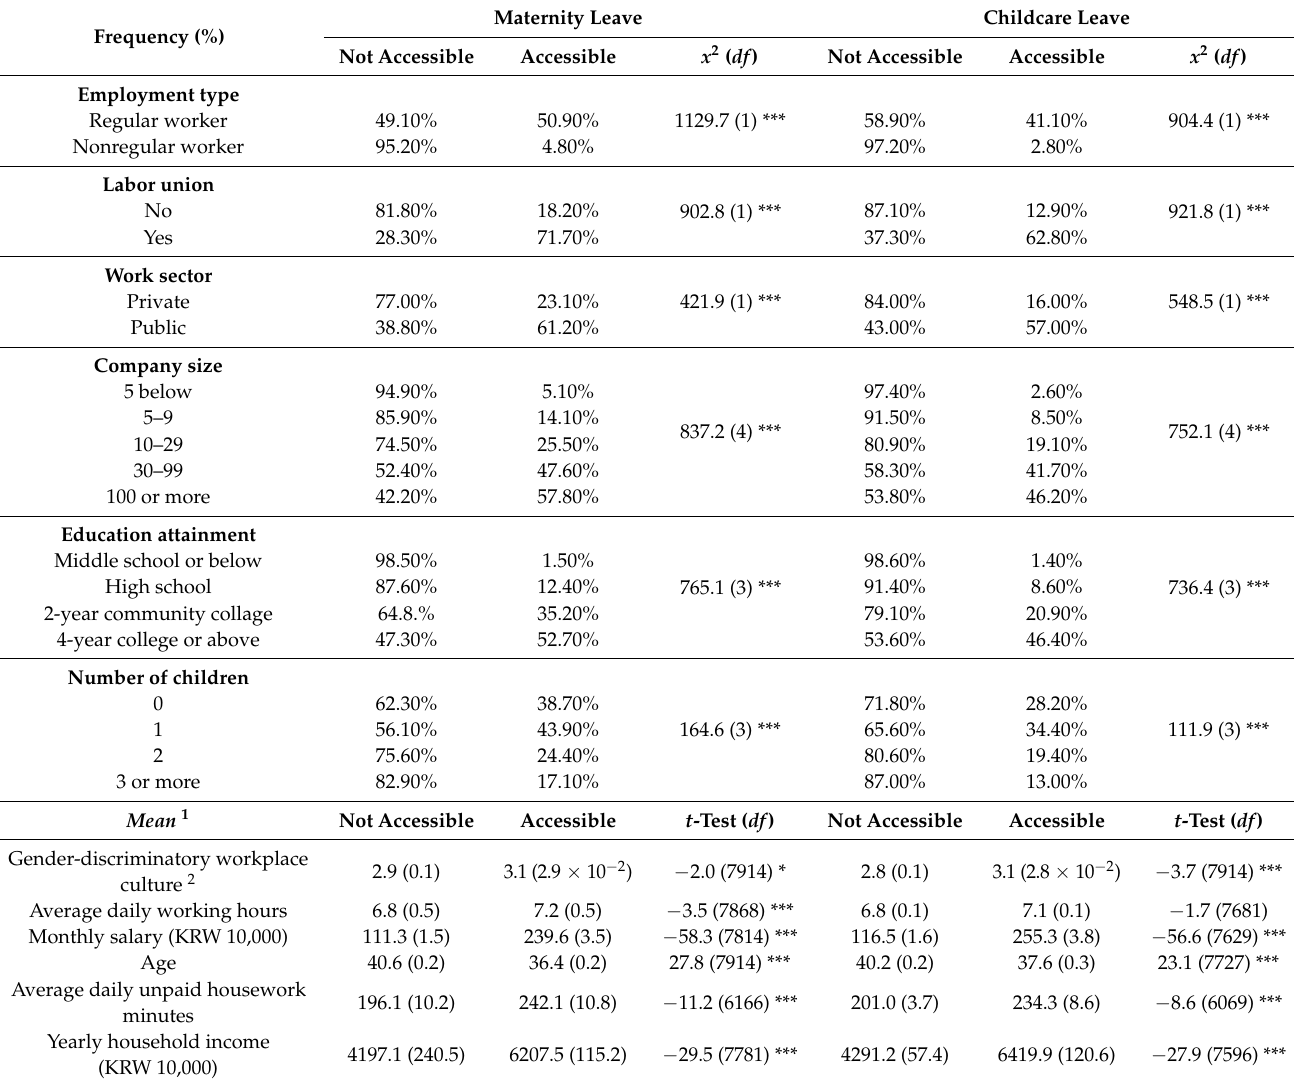
Table 3. Bivariate analyses ( N =